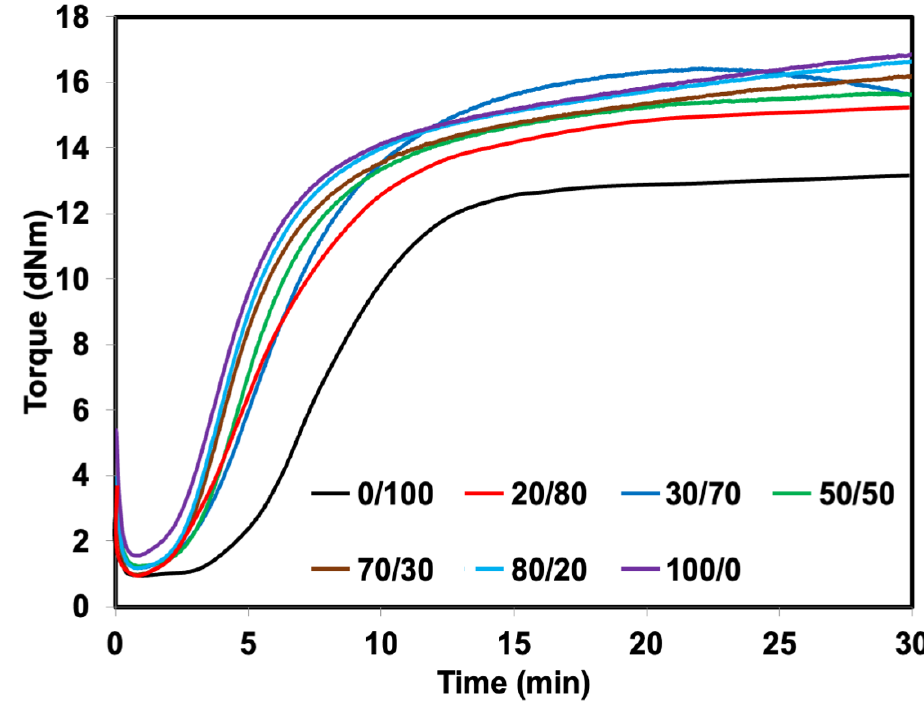
Figure 3. Rheometric curves of SR/NR blends.